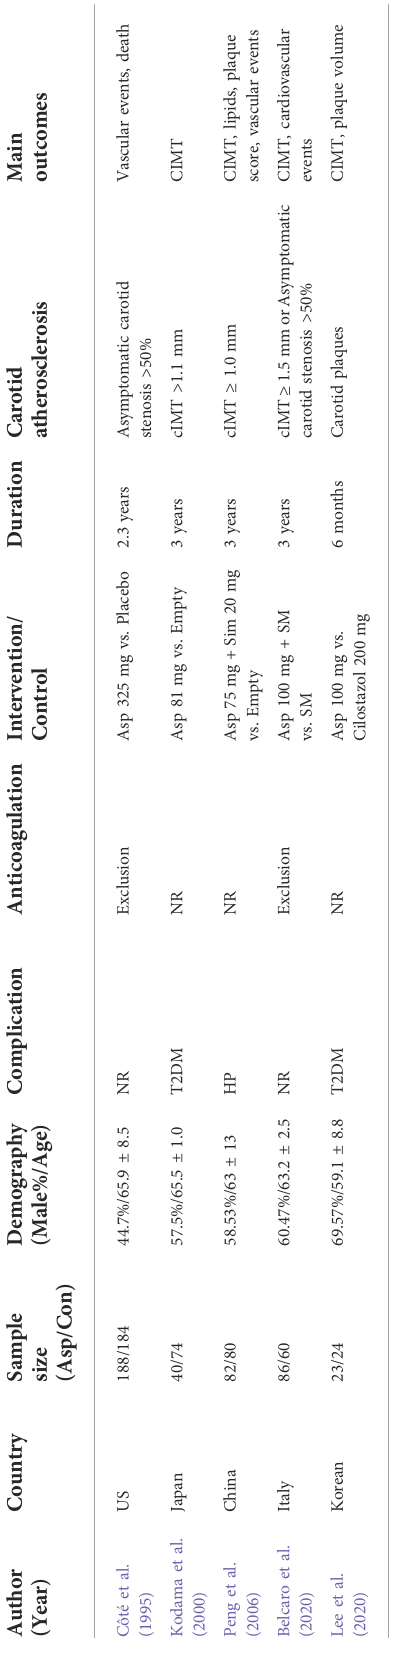
(Figure 9). For the outcome events, including cardiovascular events, cerebrovascular events and all-cause death, there were no statistical signi fi cance between aspirin group and control group when patients classi fi ed by different cIMT (Figure